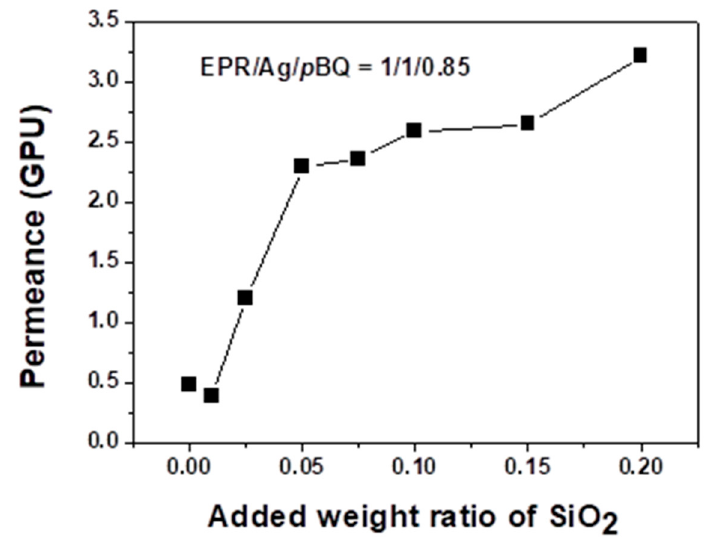
Figure 3. Separation performance: mixed gas permeance of EPR/Ag metal/ p- BQ membranes with various weight ratios of fumed silica nanoparticles.